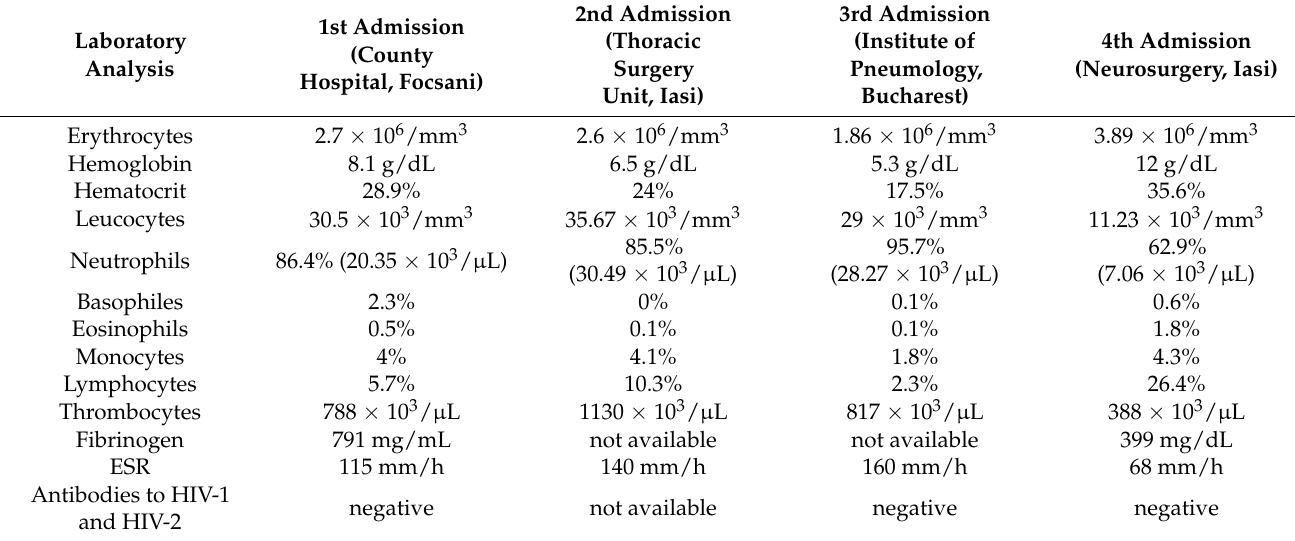
Table 1. Evolution of the biological parameters during the evolution of the